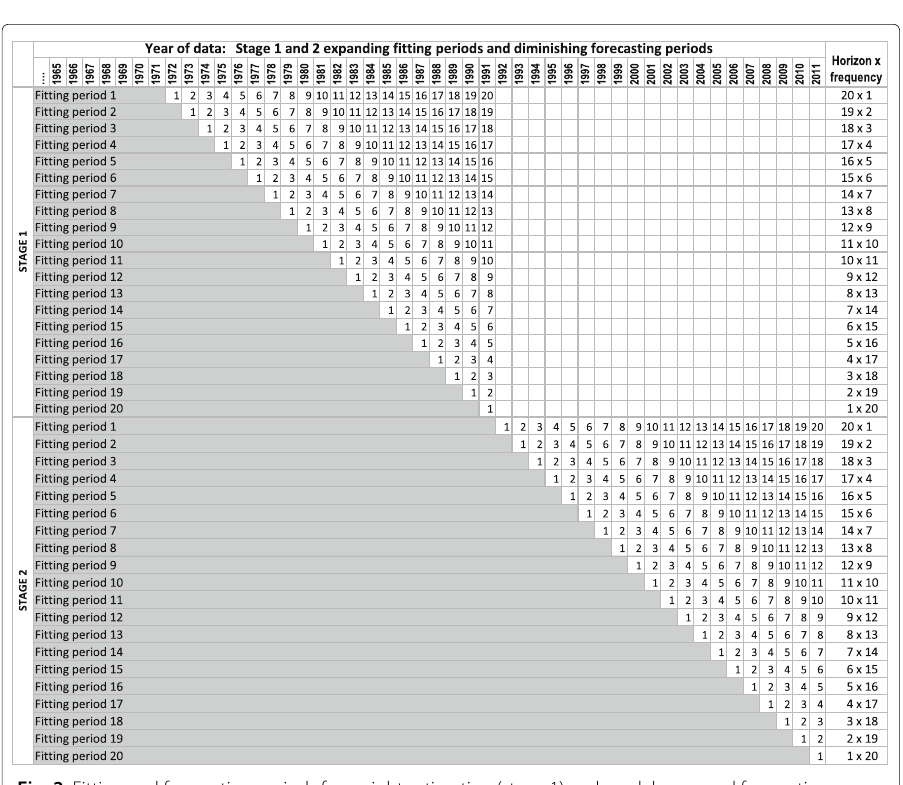
Fig. 2 Fitting and forecasting periods for weight estimation (stage 1) and model-averaged forecasting (stage 2). The start of the fitting period is determined by data availability or purposive